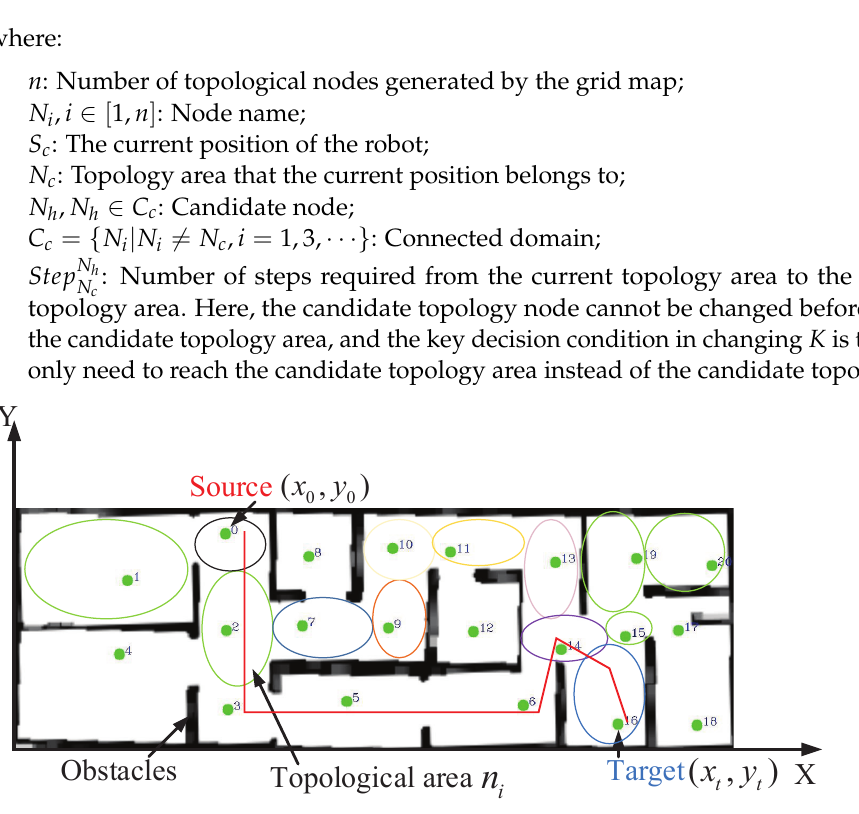
Figure 1. The schematic diagram of path planning mathematical model based on topological map. In the figure, ( x 0 , y 0 ) is the starting point , ( x t , y t ) is the the end point and the green points 1–18 are the topological nodes representing the topological